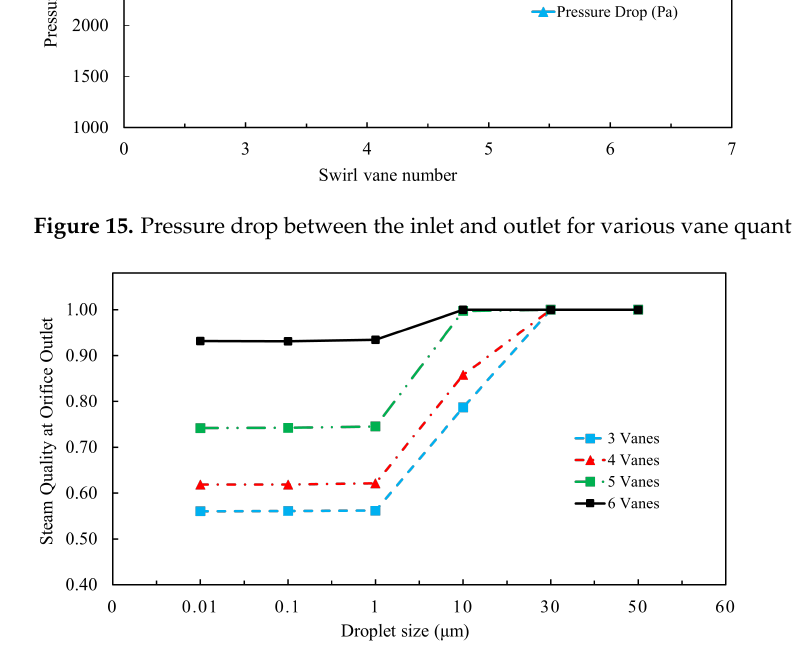
Figure 16. Steam quality at the orifice outlet for various droplet sizes and vane